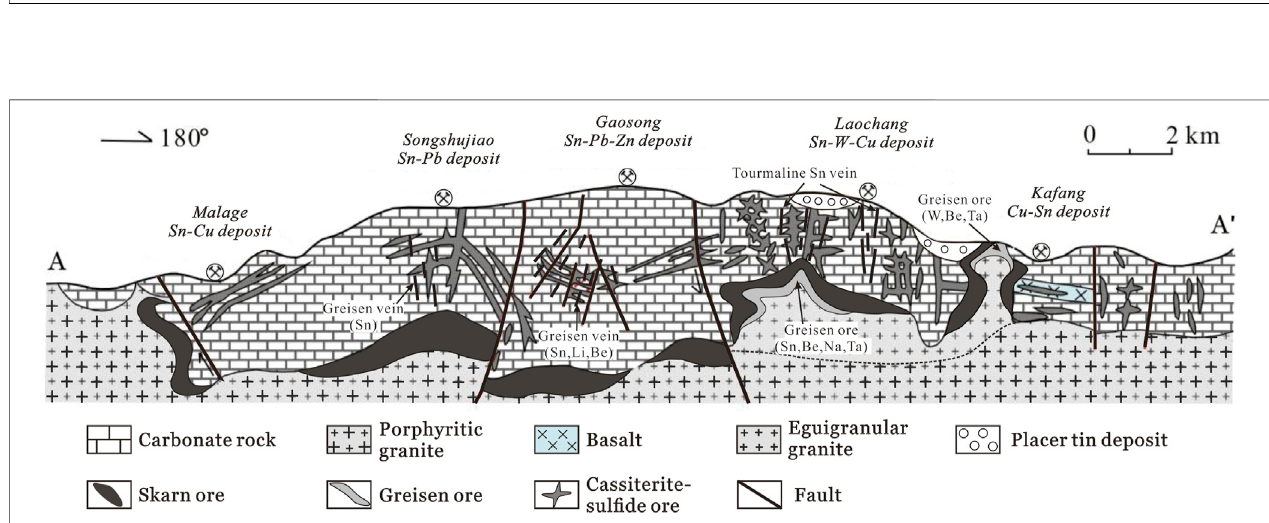
FIGURE2| Generalizedcross – sectionoftheGejiuSn – Cupolymetallicdepositsshowingthemainfeaturesofmineralizationandalteration[modi fi edfromMlnluand Kwak (1994) and Cheng et al. (2013)]. A – A ′ cross – sectional location, see Figure 1 .